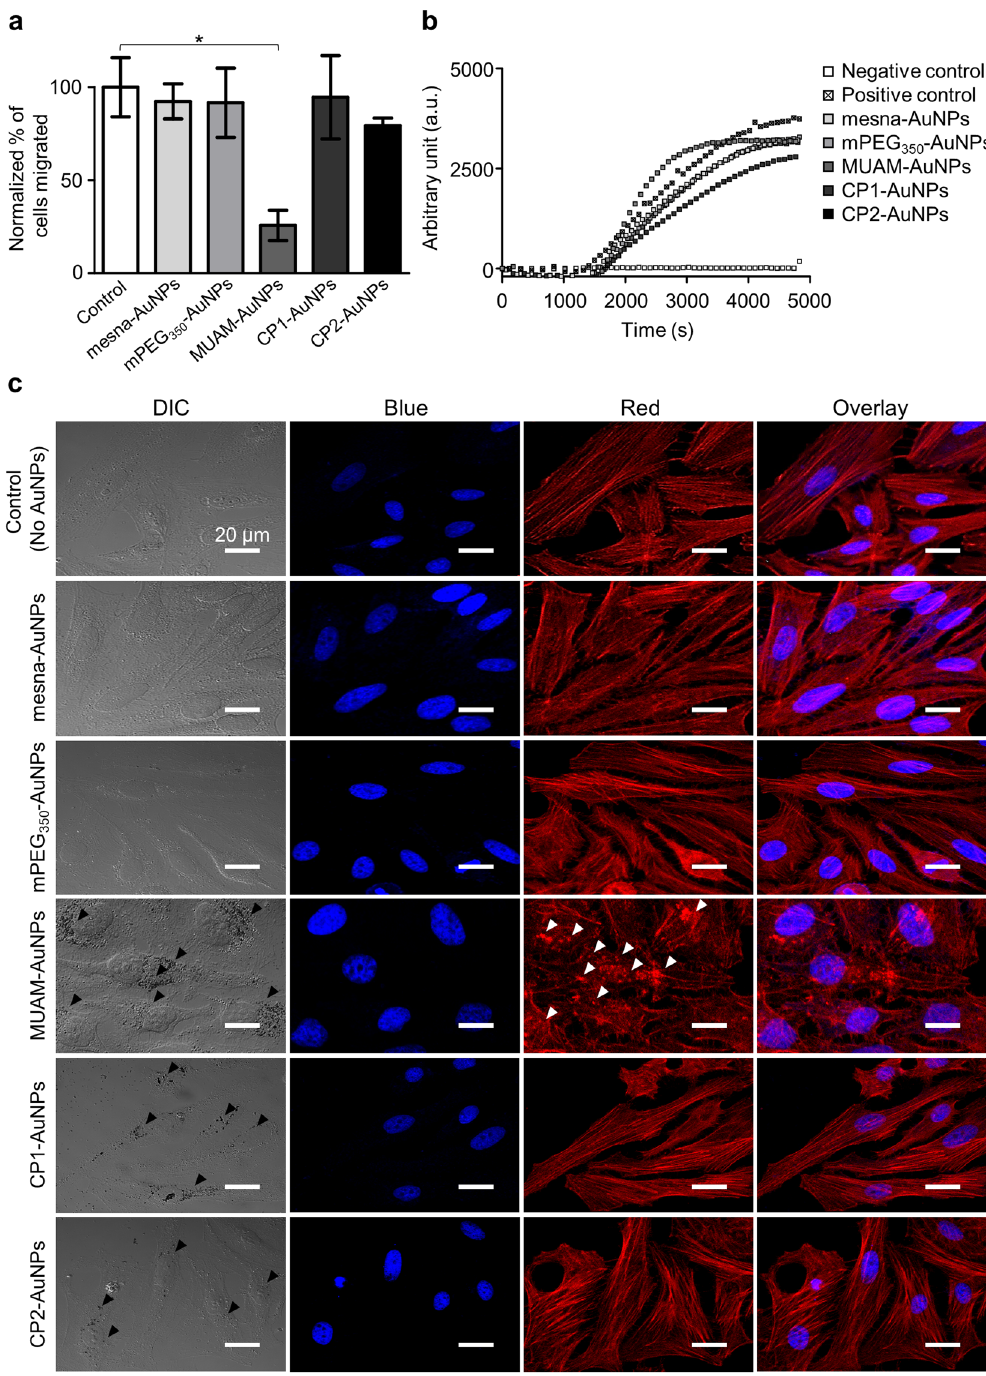
Figure 3. Effect of modified gold nanoparticles (AuNPs) on cell motility. ( a ) The motility of AuNPs-treated cells were monitored via a gap-filling assay. The migration rate decreased when cells were treated with MUAM- AuNPs (10 μ g/ml) ( * p < 0.05 , one-way ANOVA). ( b ) In vitro actin polymerization assay was performed on HeLa cells treated with modified AuNPs (10 μ g/ml). The rate of actin polymerization did not change noticeably when treated with AuNPs. ( c ) Cytoskeletal structures in AuNPs-treated cells were visualized using fluorescent phalloidin (DAPI-stained nucleus, blue; actin filaments, red). F-actins in MUAM-AuNPs treated cells were disassembled and fragmented (white arrows). Scale bar: 50 μ